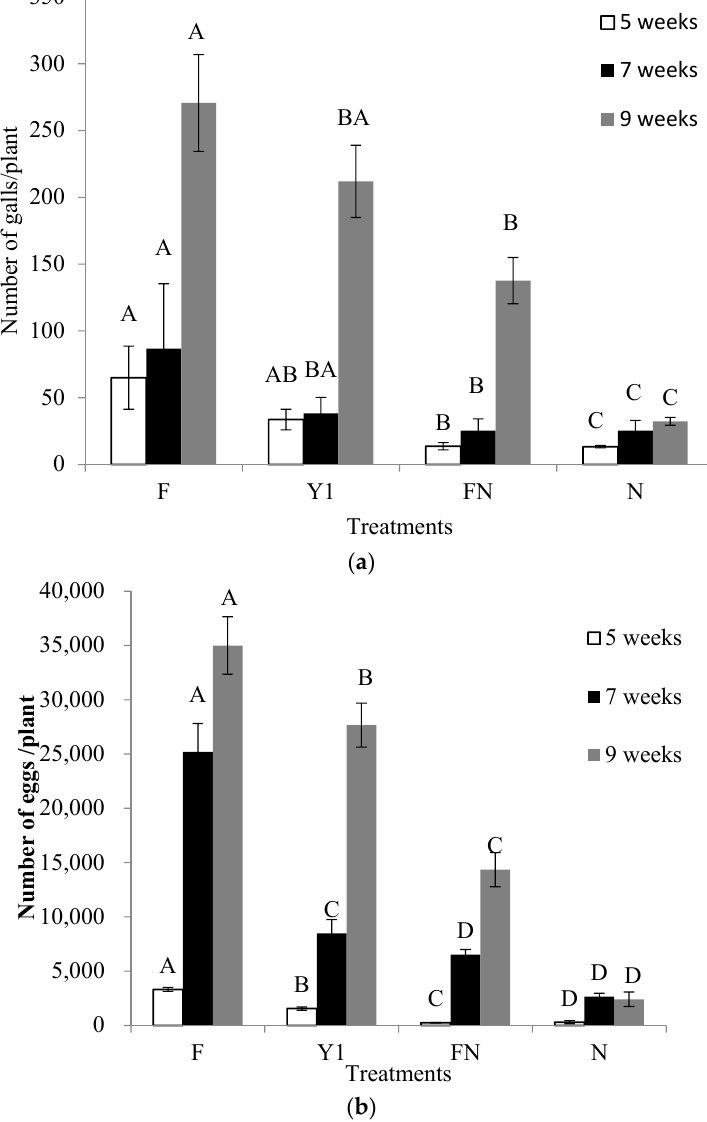
Figure 7. Effect of B. amyloliquefaciens Y1 on number of ( a ) galls and ( b ) eggs per tomato plants root treated with fertilizer medium (F), bacterial culture (Y1), fertilizer medium + commercial nematicide (FN) and commercial nematicide (N) at 5, 7 and 9 weeks after M. incognita infestation. Fertilizer medium was used as control and Mocap was used once as nematacide. Error bars represent standard error of the mean from four replicates. Means with the same letter in same observation time are not significantly different at p ≤ 0.05 when compared with